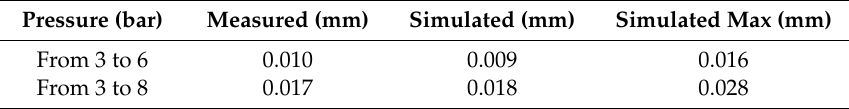
Table 1. Distance variation with respect to 3 bar.